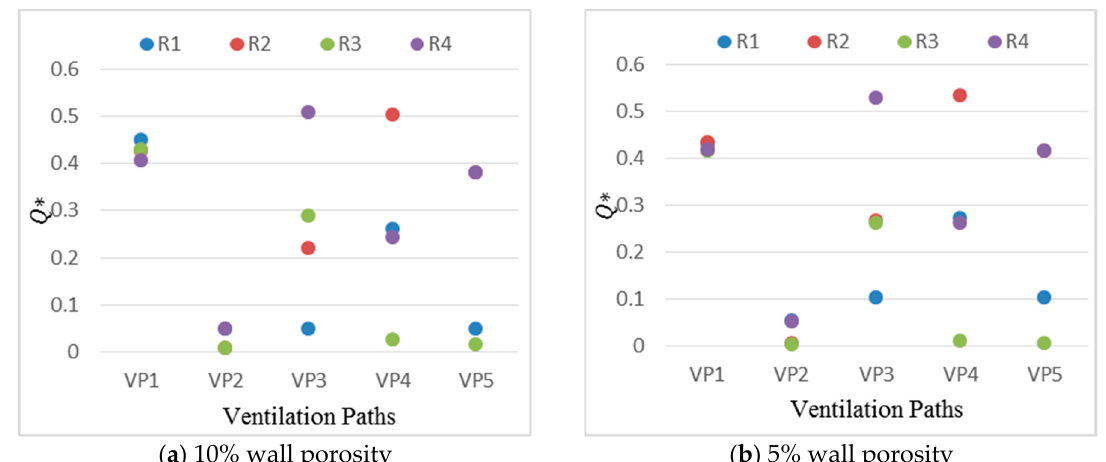
Figure 7. Non-dimensional ventilation rate ( Q ∗ ) in each room under five ventilation paths with two types of windward wall porosities. ( a ) 10% wall porosity; ( b ) 5% wall porosity.